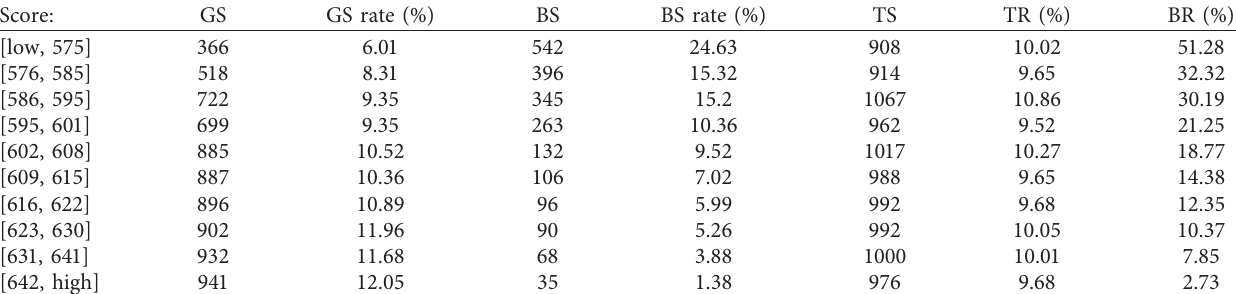
Table 7: Test set sample score.